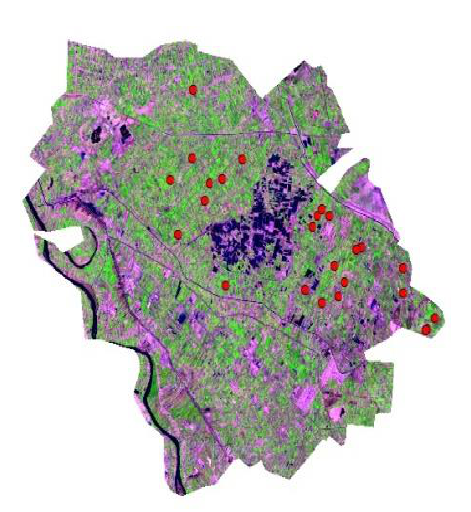
Fig.2: The location of the groundwater samples.